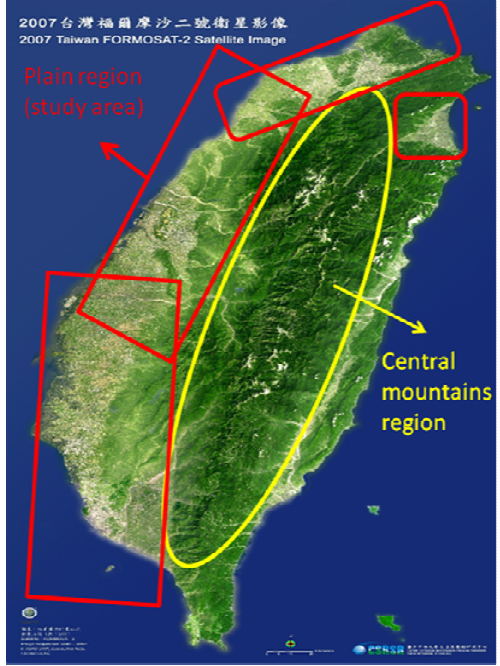
Figure 26. The terrain of Taiwan (FORMOSAT-2 Satellite Image, Courtesy of CSRSR, NCU,